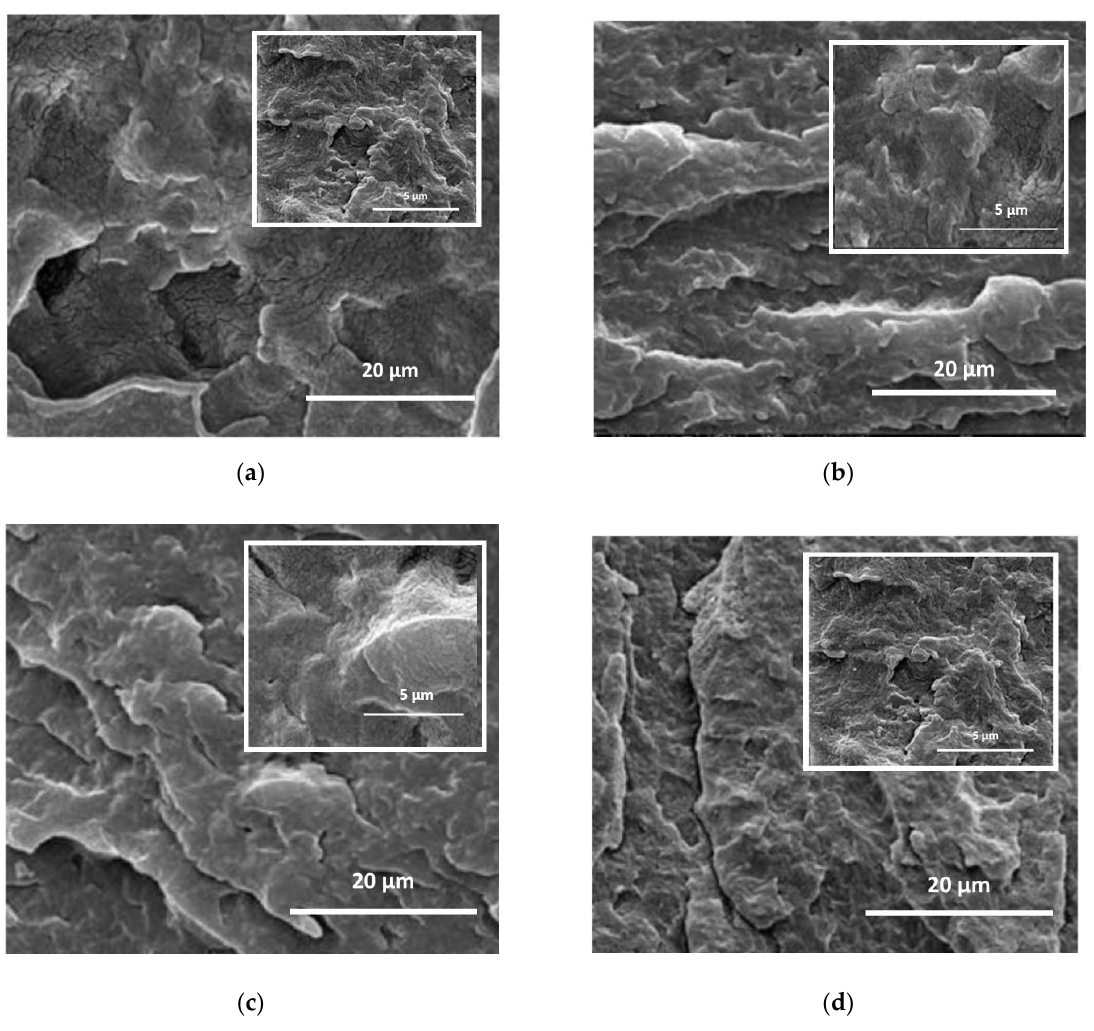
Figure 5. SEM images at different magnifications of ( a ) PA11/LDH-NO3, ( b ) PA11/LDH-HALS1, ( c ) PA11/LDH-HALS2 and ( d ) PA11/LDH-HALS added